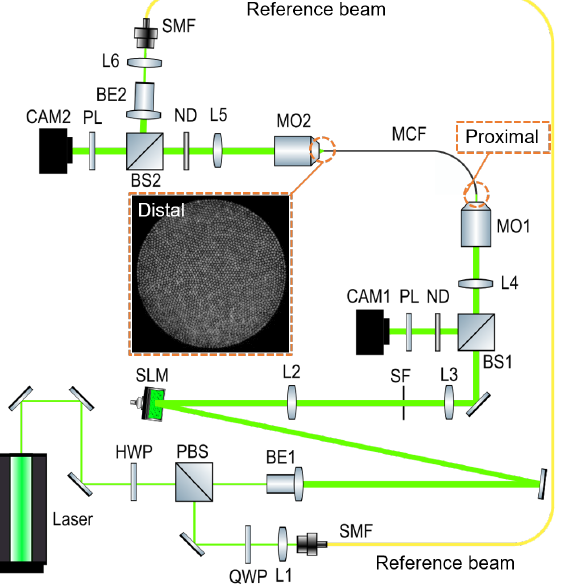
Figure 1. Sketch of the experimental setup. A microscopic image of the distal facet of the MCF is shown in the middle of the figure. HWP, half-wave plate; PBS, polarizing beamsplitter; BE, beam expander; QWP, quarter-wave plate; L, lenses; SMF, single-mode fiber; SLM, spatial light modulator; SF, spatial filter; BS, beamsplitter; ND, neutral density filters; CAM, CMOS cameras; MO, microscope objectives; MCF, multi-core fiber; PL,